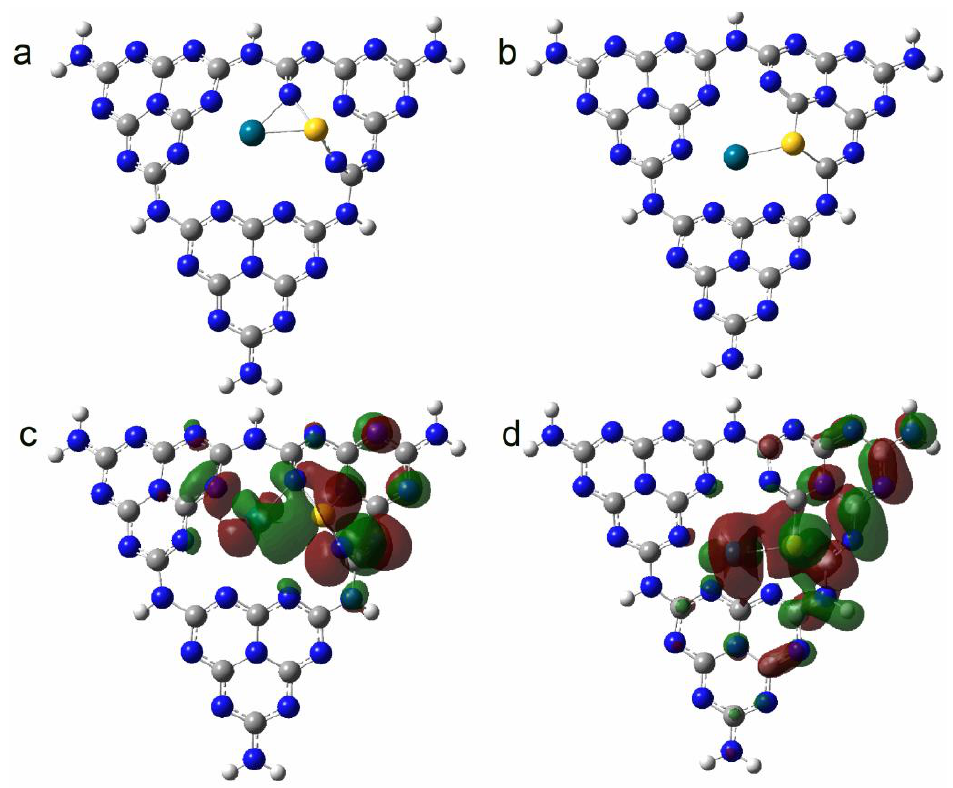
Figure 2. Optimal adsorption structure of Pd atoms on S-doped g-C 3 N 4 and their corresponding highest occupied orbital.